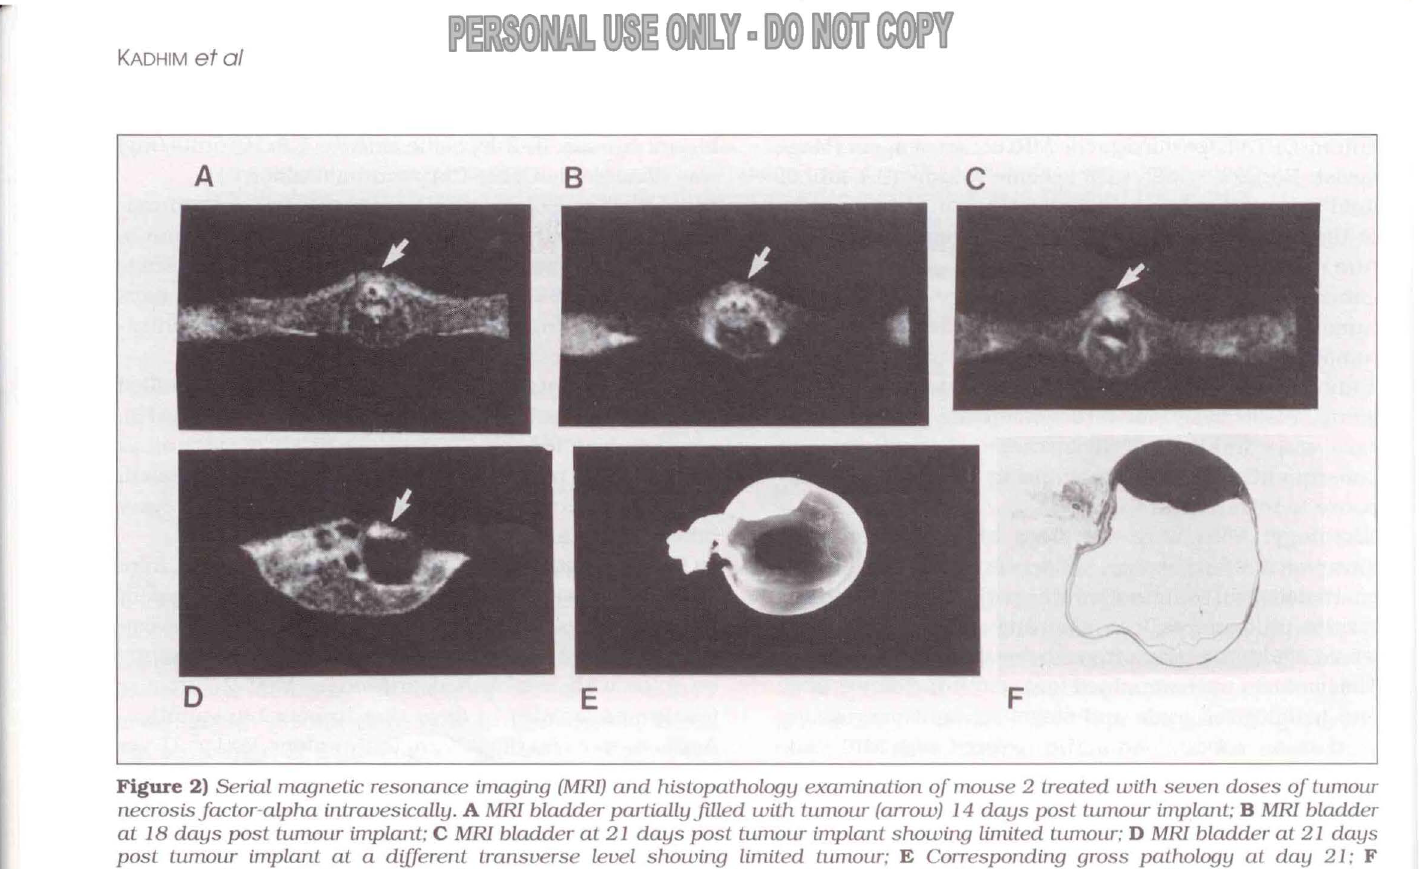
Figure 2) Serial magnetic resonance imaging (MRI) and histopathology examination of mouse 2 treated with seven doses of tumour necrosis factor-alpha intravesically. A MRI bladder partially filled with tumour (arrow) 14 days post tumour implant; B MRI bladder